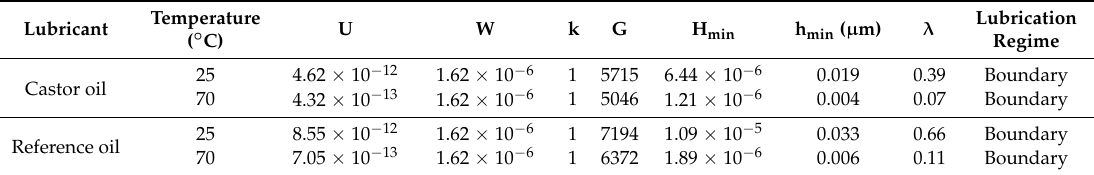
Table A2. Estimation of Lubrication regime for Castor and Reference